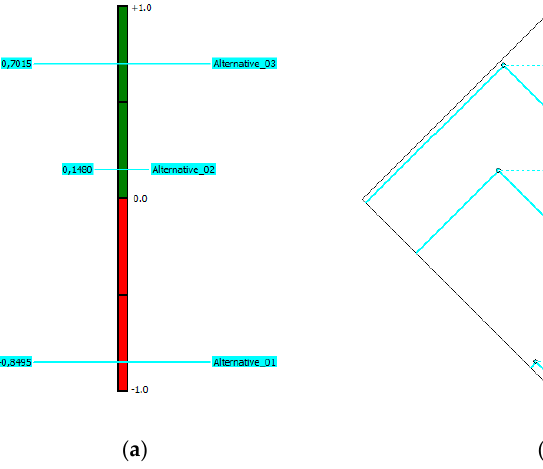
Figure 6. Results of multicriteria analysis from the SPUR model by means of the VisualPROMETHEE software: ( a ) PROMETHEE II; ( b ) PROMETHEE Diamond; ( c ) PROMETHEE Network.